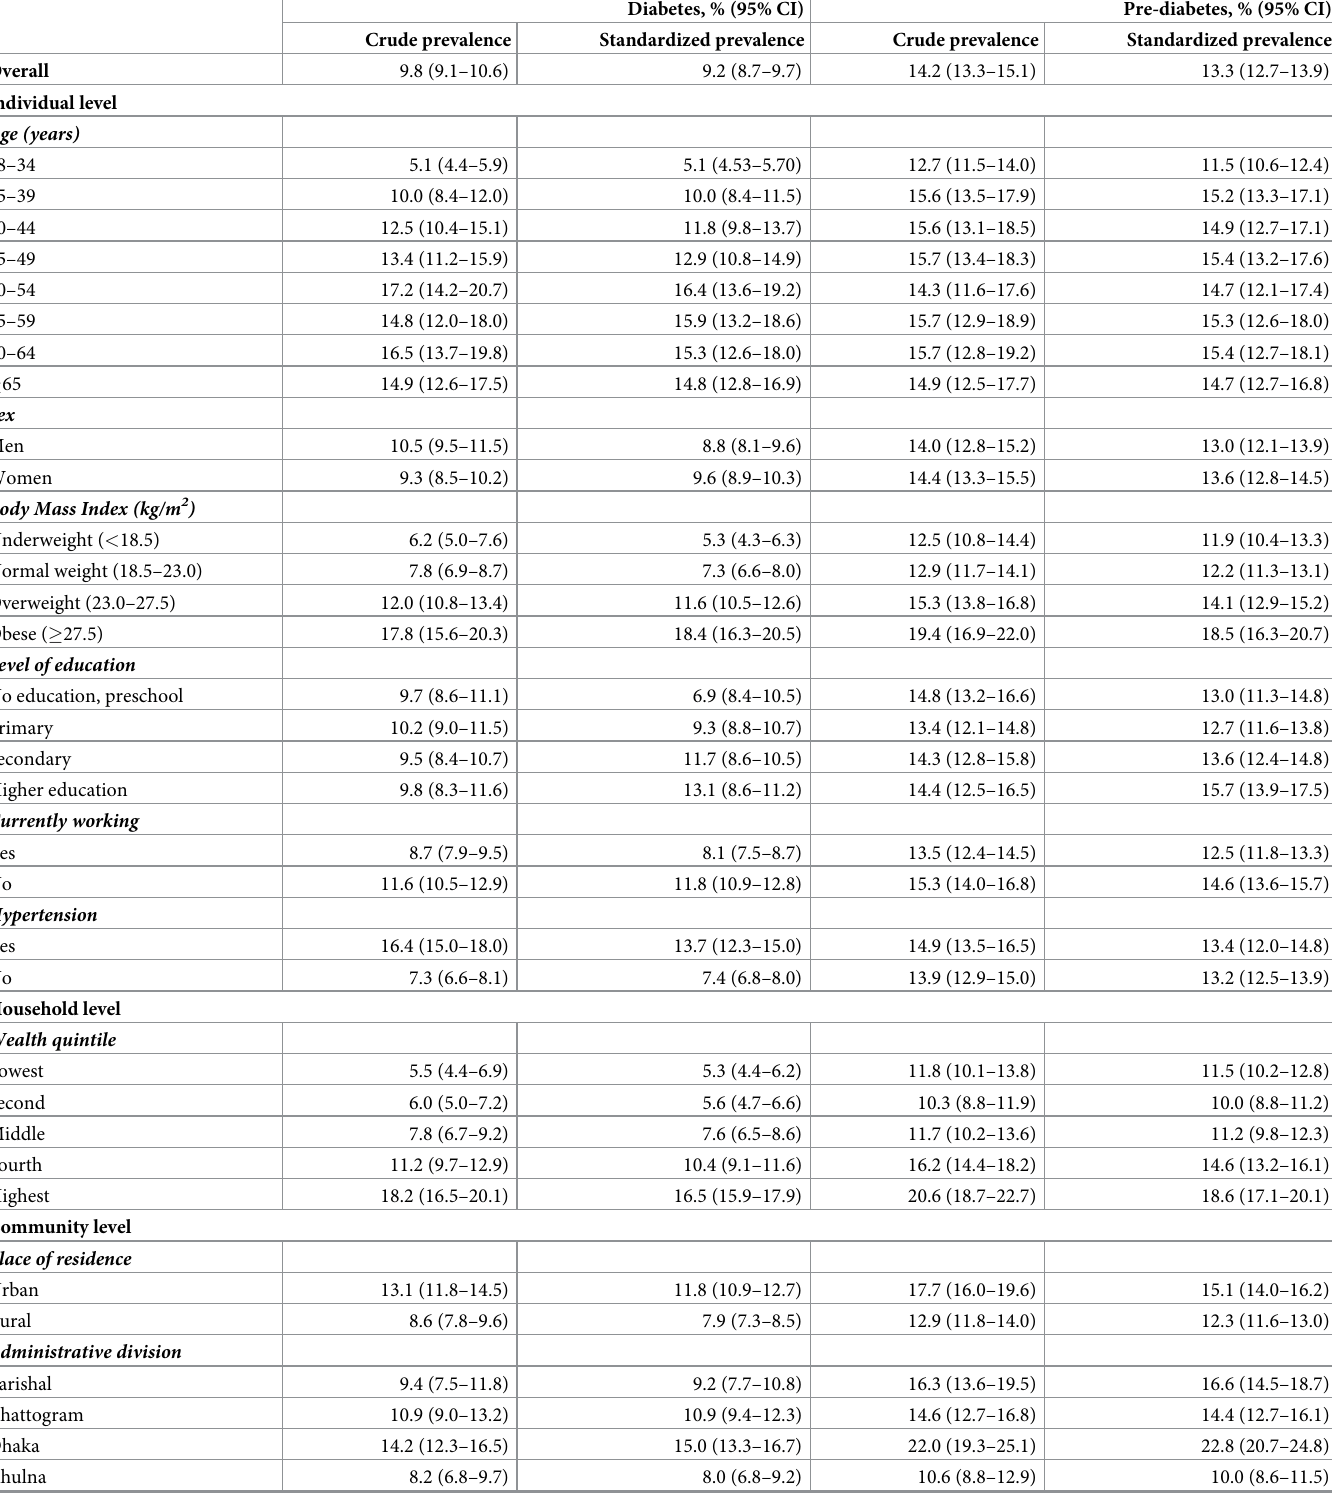
Table 2. Crude and age-standardized prevalence of diabetes and pre-diabetes in adults aged � 18 years in Bangladeshi population, BDHS